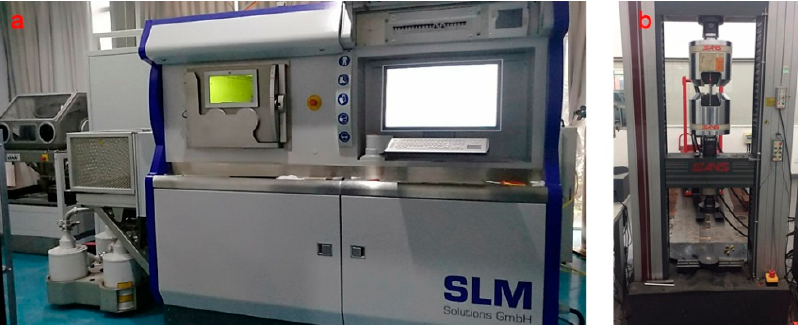
Figure 9. Experimental apparatus : ( a ) SLM500HL laser melting rapid prototyping machine; ( b ) universal material testing machine. Table 4. Primary SLM500HL parameters.